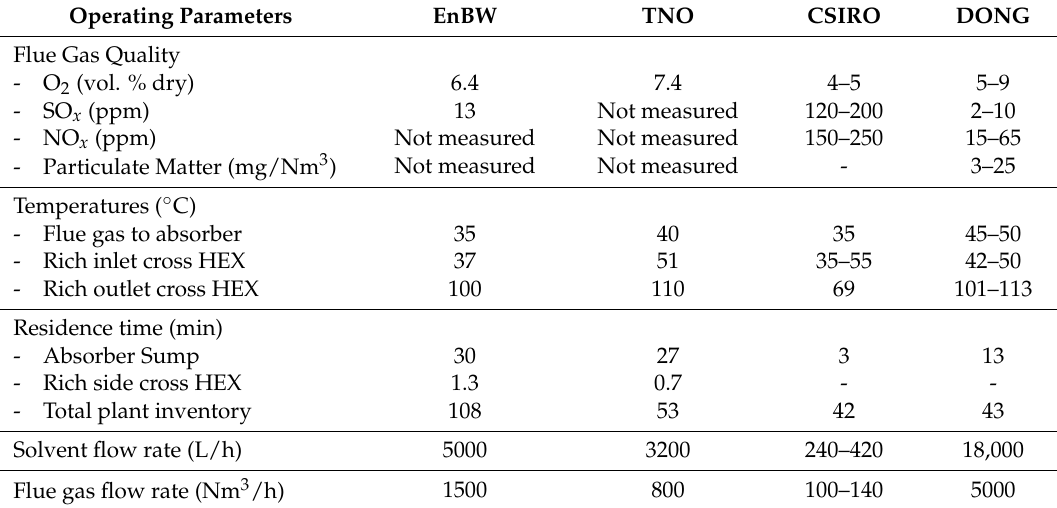
Table 1. Operating parameters at the different pilot